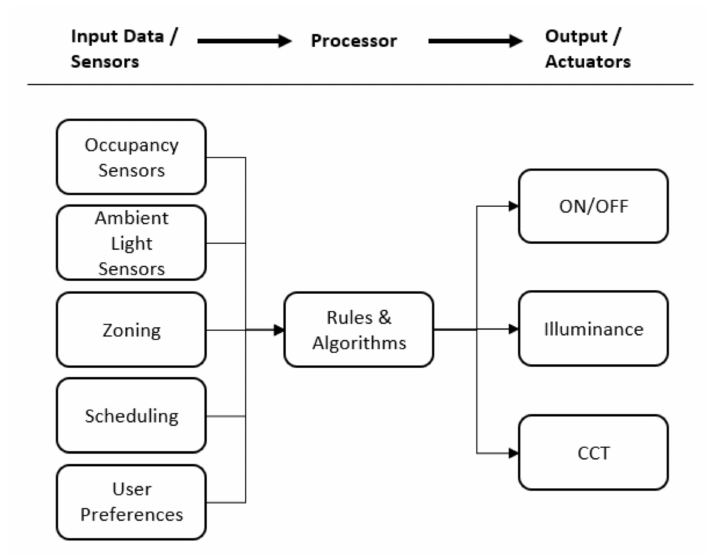
Figure 1. A general lighting control system model based on Martirano’s [20] control